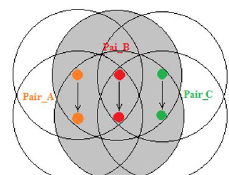
Figure 3: Three pairs scenario (Scenario 2).